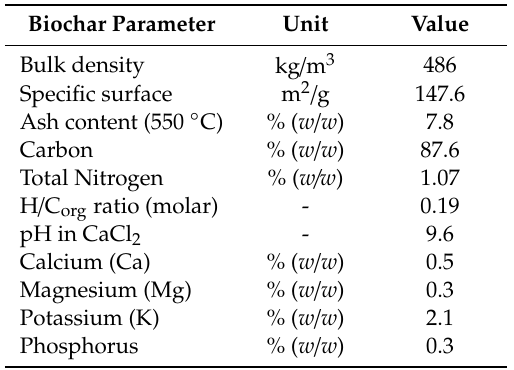
Table 1. Biochar properties according to the methodology of the European Biochar Certificate [32]. Biochar Parameter Unit